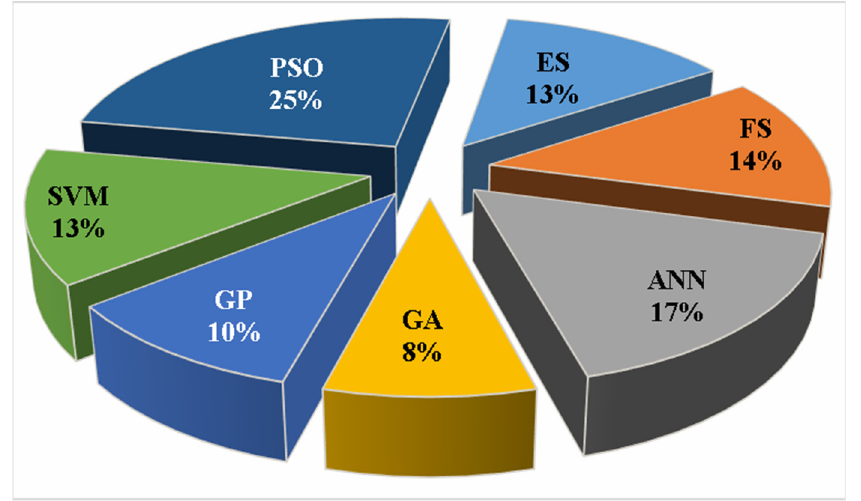
Figure 17. Implementation of each considered AI techniques in infrastructure projects.